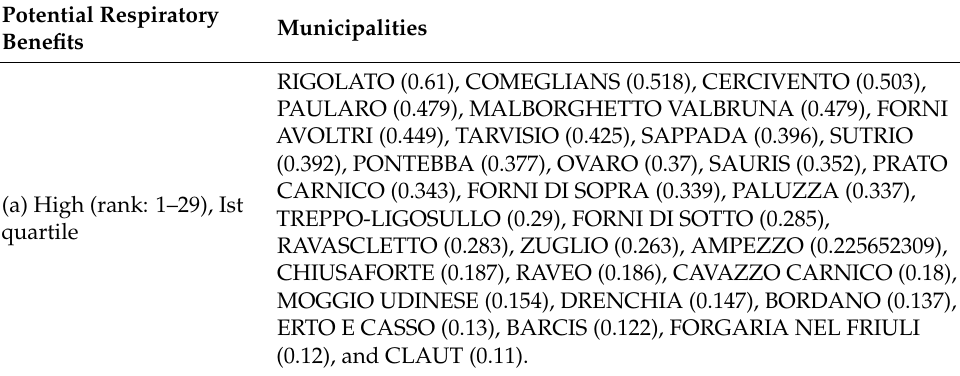
Table 7. Overall potential respiratory benefits of forest heritage by municipality through applying models P1–3.